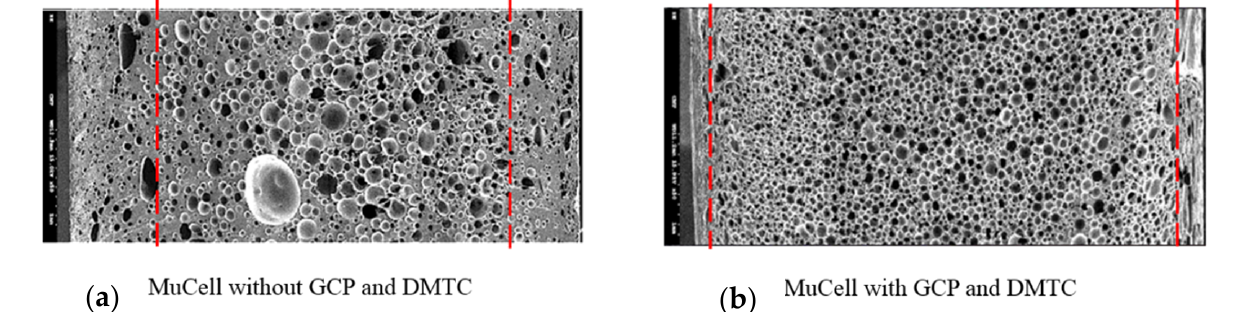
paths) is illustrated.